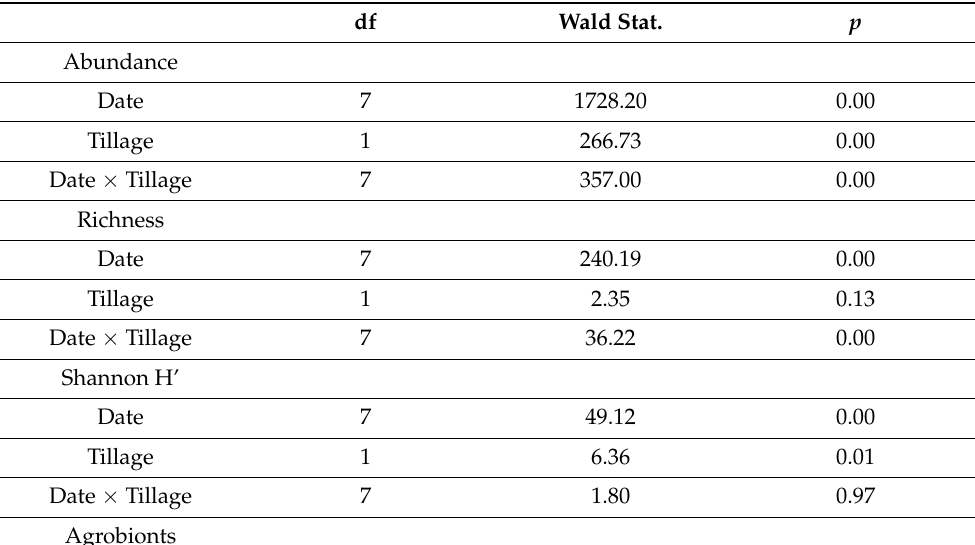
Table 3. Results of the GLM test of significance (Wald statistic) of the effect of type of soil tillage and period when sampled on abundance and species richness of spiders and abundance of ecological